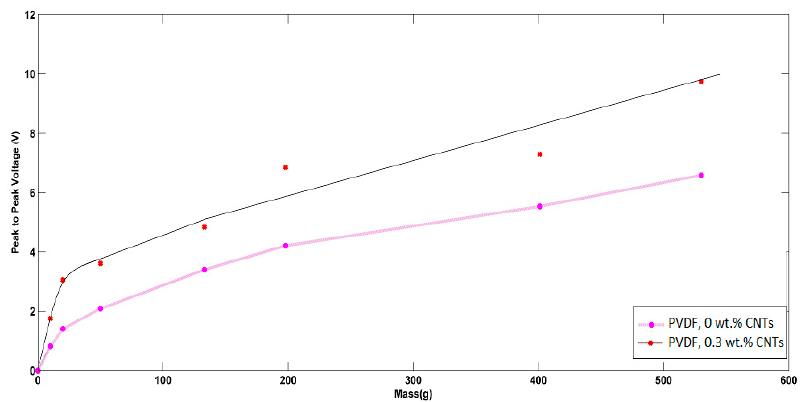
Figure 10. Piezoelectric response of non-aligned nanofibers at different added weight ratios of CNTs.